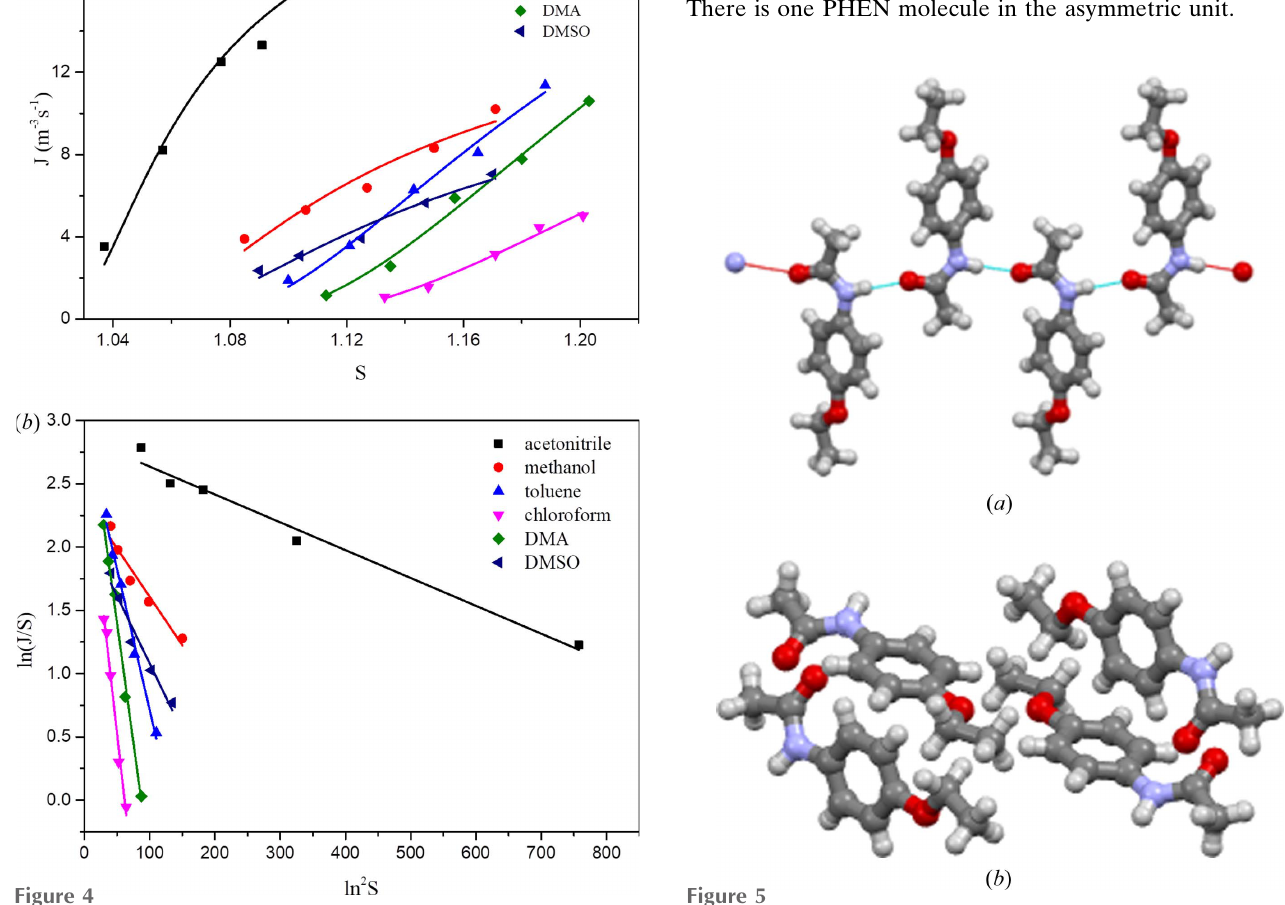
Figure 5 ( a ) Crystal packing of form I along the c axis; ( b ) C—H (cid:8)(cid:8)(cid:8) (cid:2) interaction in form